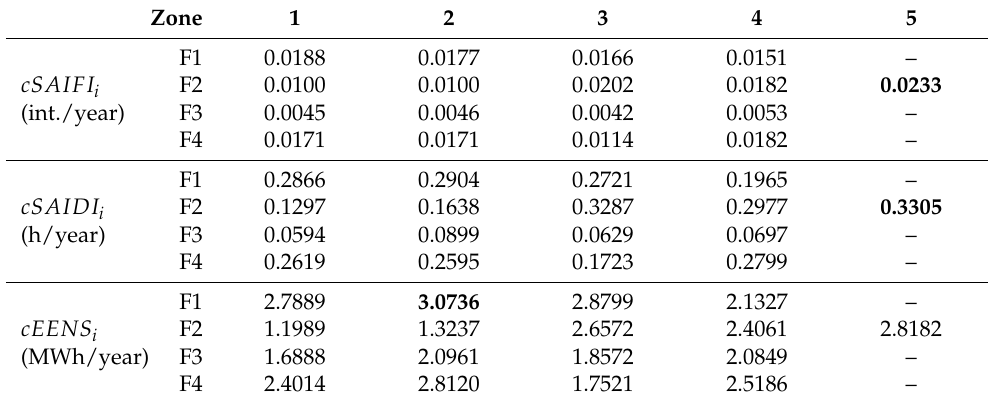
Table 6. Contribution of faults in zones to the reliability indices obtained using the proposed method.